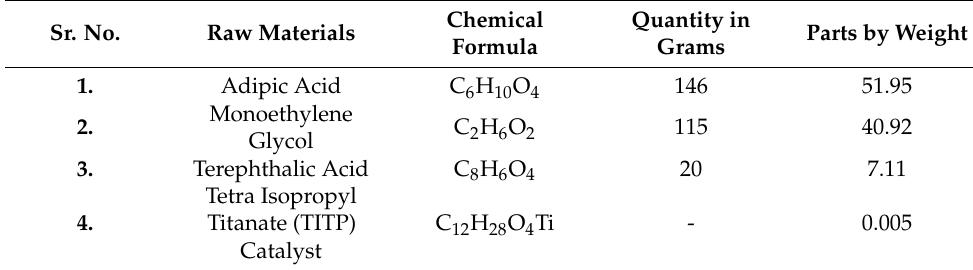
Table 1. Composition of polyester polyol. Sr.